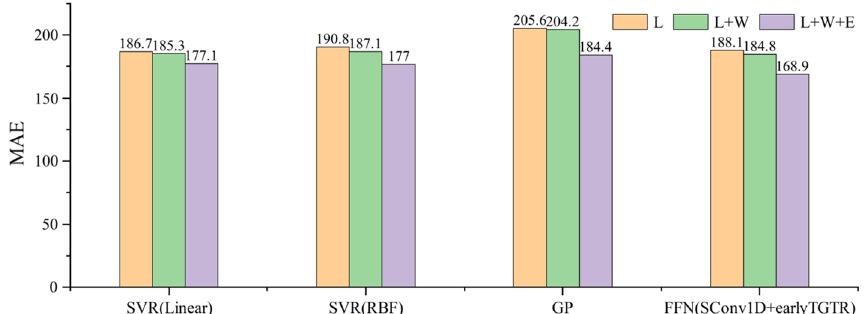
Fig. 5 Incremental experiments with different methods